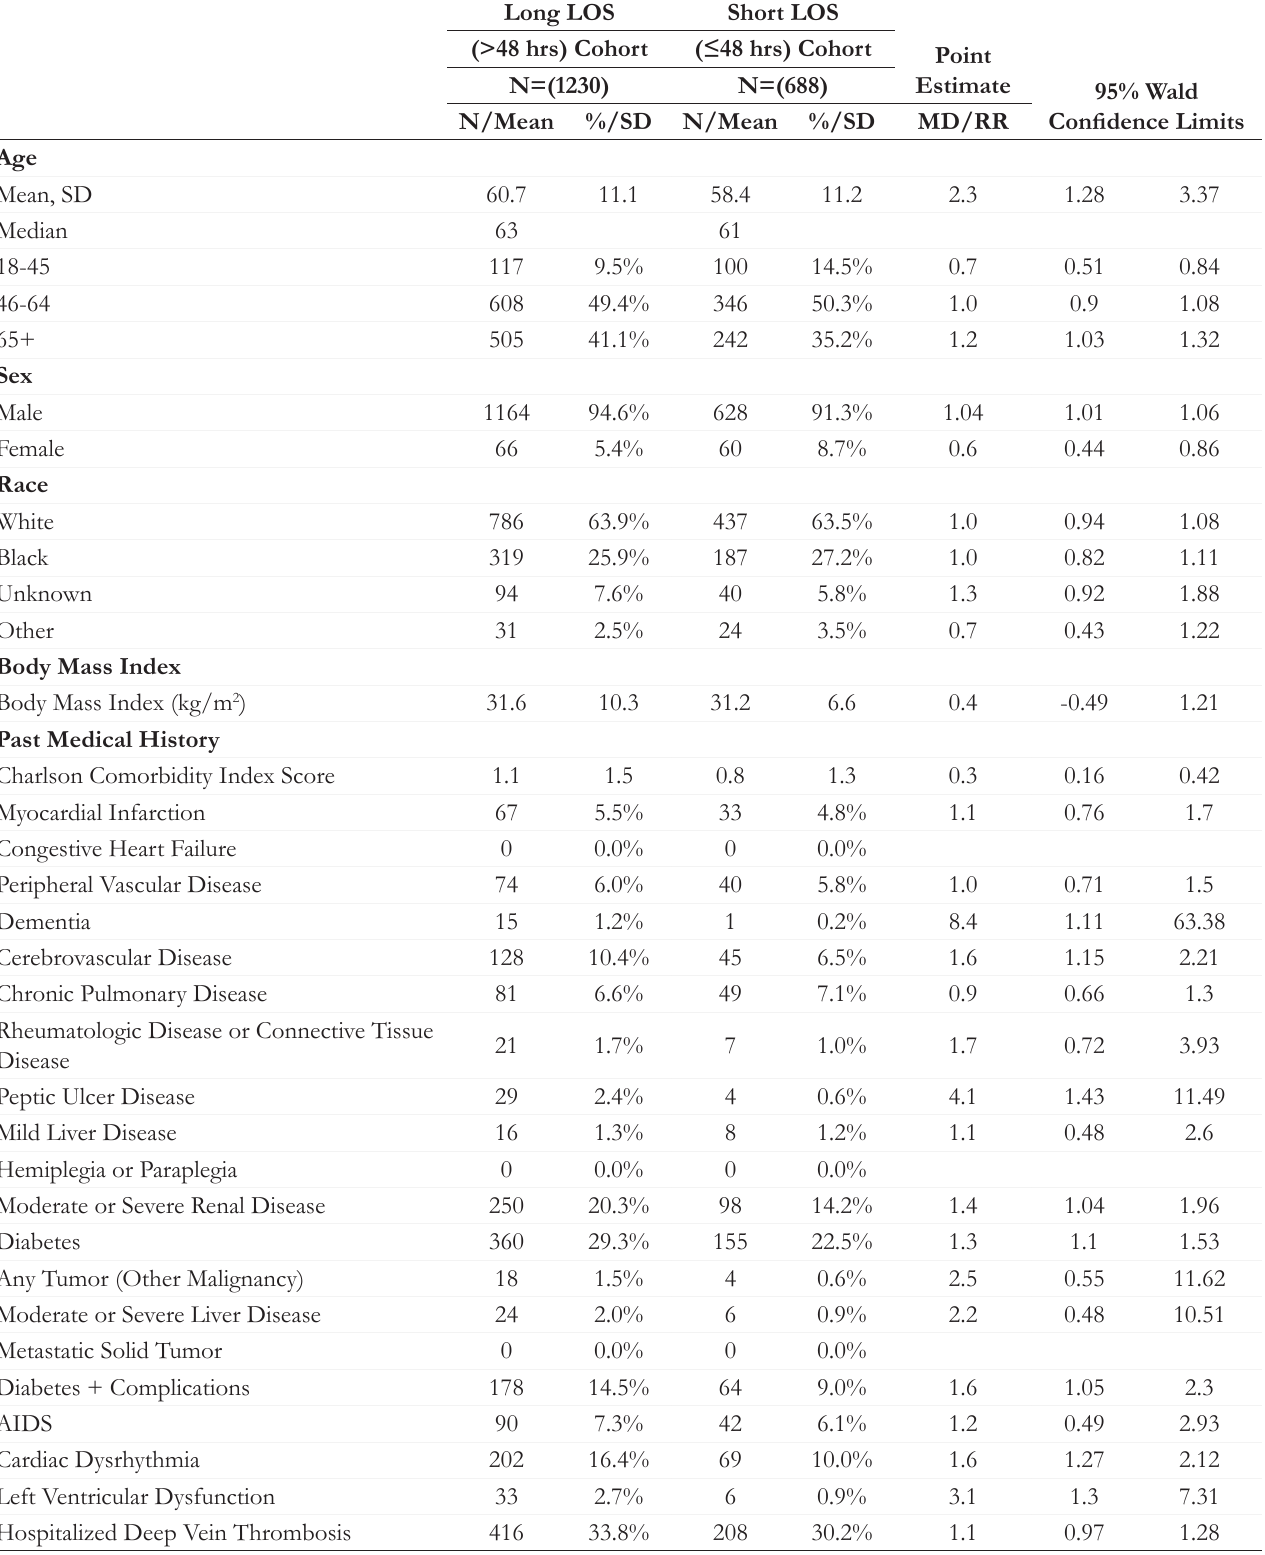
Table 1. Baseline Demographic and Clinical Characteristics of LRPE Patients with Long versus Short